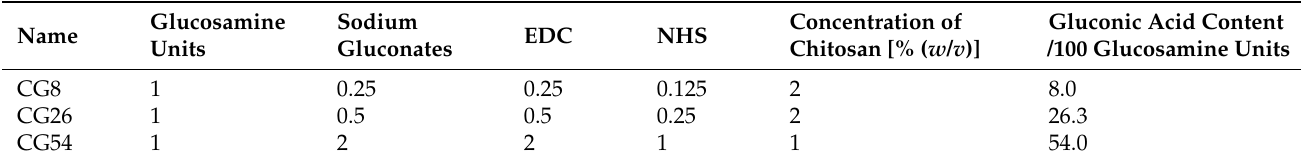
Table 1. Feeding molar ratios of sodium gluconate, EDC, and NHS to glucosamine units to synthesize the three types of CG and the gluconic acid content of the